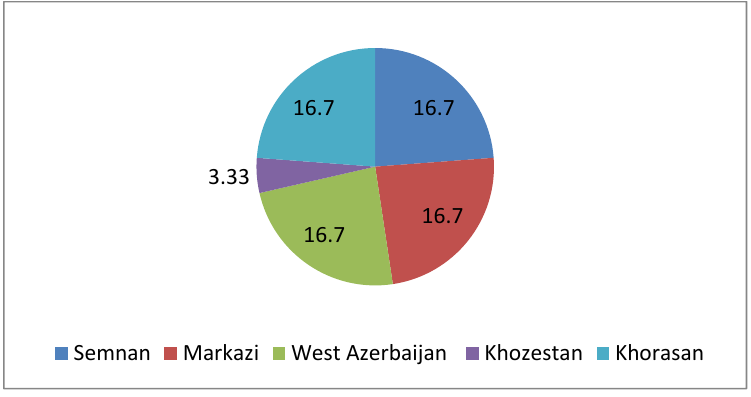
Fig. 1. Distribution of the survey in different